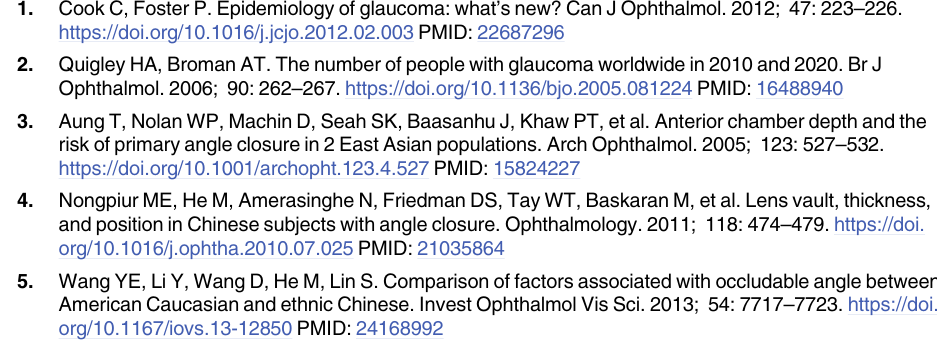
S1 Table. Intraobserver repeatability of anterior segment parameters in 60 recruited